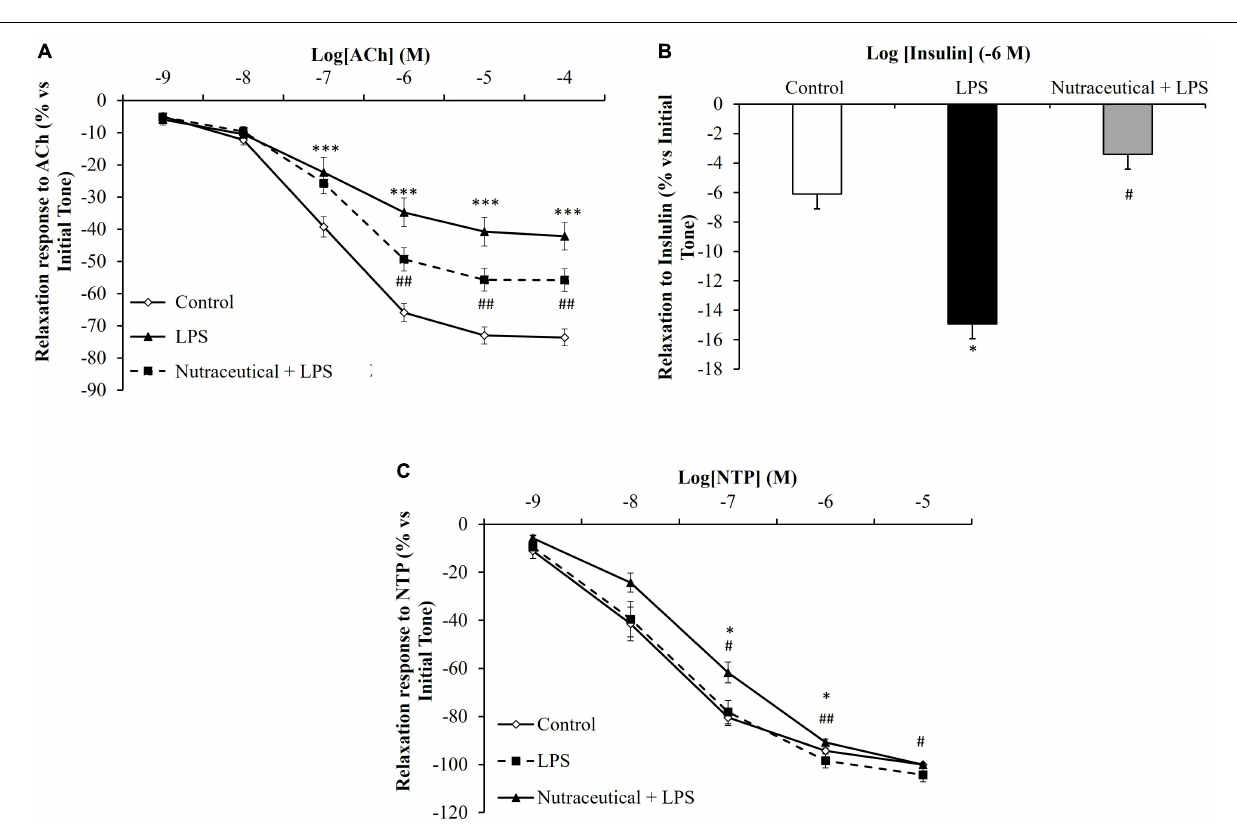
FIGURE 4 | Relaxation response of thoracic aortic segments to acetylcholine (A) , to insulin (B) and to sodium nitroprusside (C) of rats treated with vehicle, LPS or LPS + Nutraceutical. Values are represented as mean ± SEM. ∗ p < 0.05 vs. Control; ∗∗∗ p < 0.001 vs. Control; # < 0.05 vs. LPS; ## p < 0.01 vs.